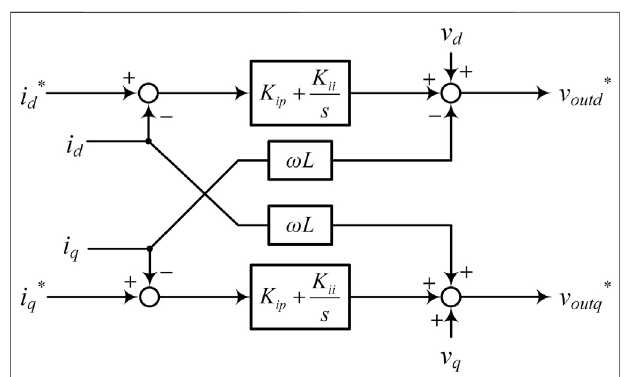
FIGURE 5 | Current control based on dq